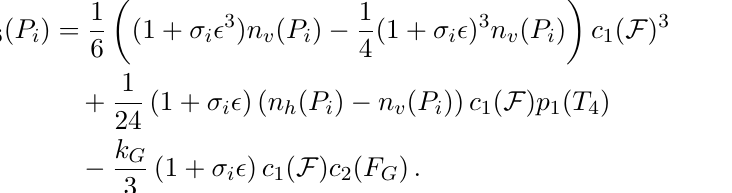
Figure 2 . Labeling Young tableaux by their pole structure p k . The first Young tableau corresponds to the minimal puncture with p = (0 ; 1 ; 1 ; 1 ; 1) . The second one is the maximal puncture with p = (0 ; 1 ; 2 ; 3 ; 4) and the third diagram corresponds to an intermediate puncture with p = (0 ; 1 ; 2 ; 2 ; 3)